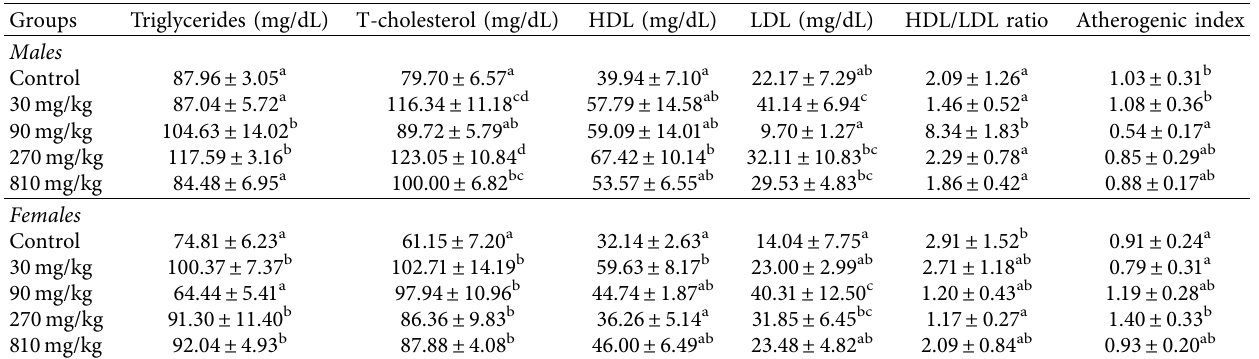
Table 7: Effect of aqueous extract of T. grandis leaves on lipid profile of animals. Groups